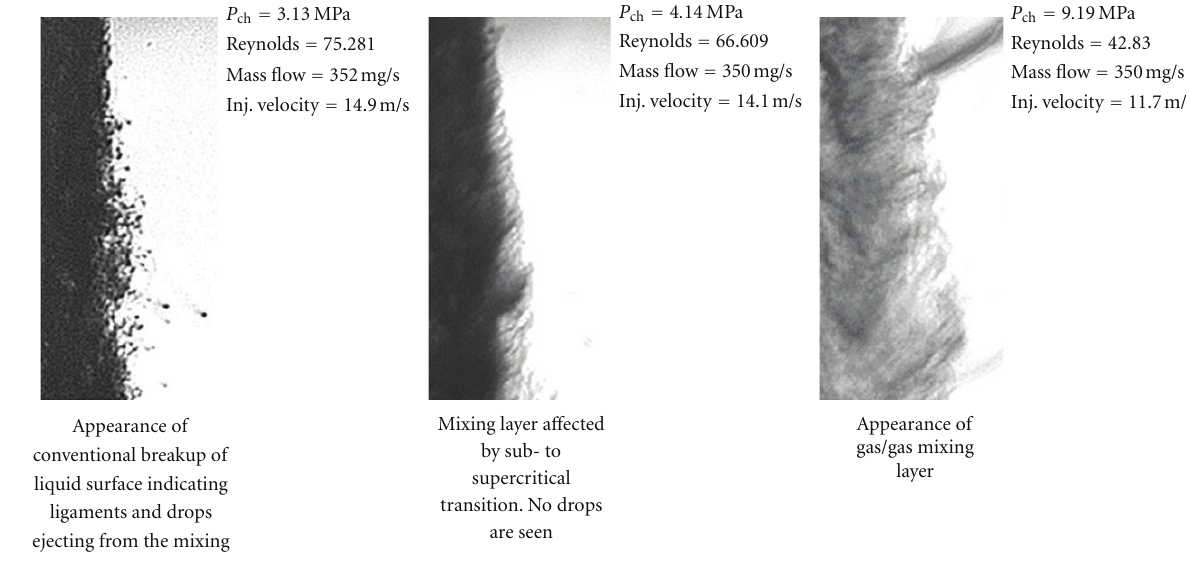
Figure 2: Software magnified images of the jets in Figure 1 at their outer boundaries showing transition to the gas-jet-like appearance starting at just below the critical pressure of the injectant. Images are at fixed supercritical chamber temperature of 300 K. Chehroudi et al.